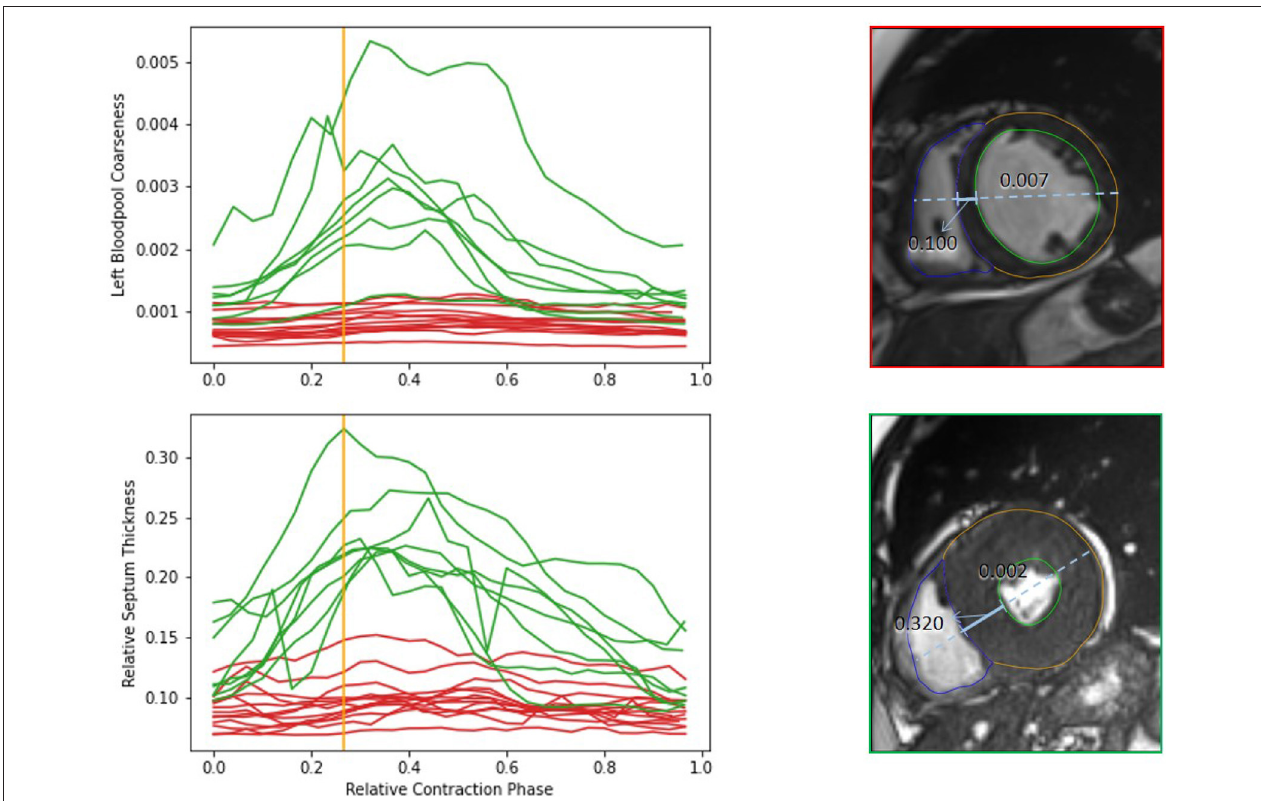
FIGURE 8 | Comparison of features of HCM (green) and DCM (red) patients from the complete dataset. The upper diagram shows dynamics of the left bloodpool coarseness over the cardiac cycle. The lower diagram display the changes of the relative septum thickness. The viewers on the right show the time frames corresponding to the orange line for an example case of a DCM and HCM patient. The solid blue line indicates the septum thickness. The dashed line shows the diameter heart diameter, that is used for normalization of the septum thickness. The coarseness of the selected timepoint is shown on top of the left blood pool. The example cases differ strongly in the anatomical relations as well as in the blood pool intensity distribution.